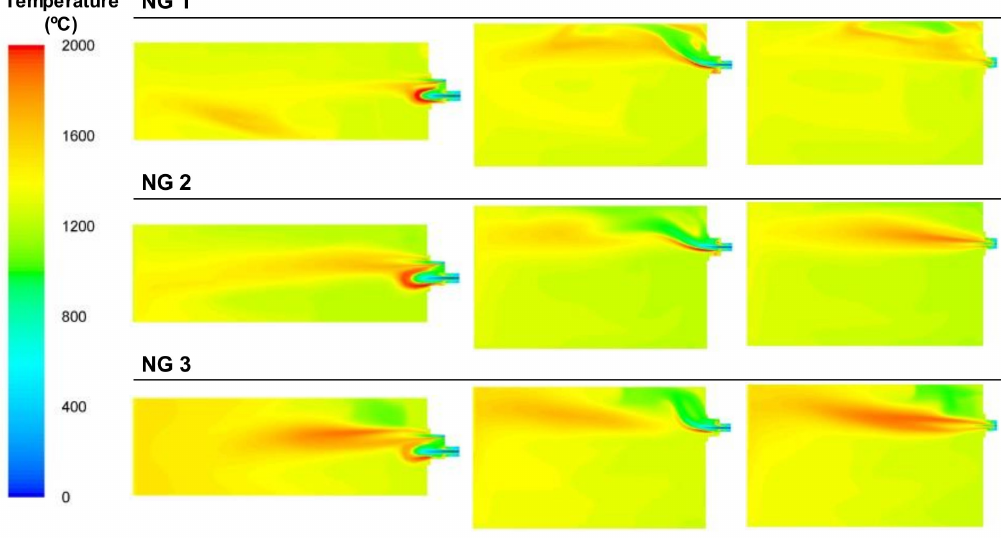
Figure 24. Contour plots of temperatures for the NG cases in the XZ1, XY1, and XY2 planes. The use of NG, which has the highest calorific value of all the fuels tested, together